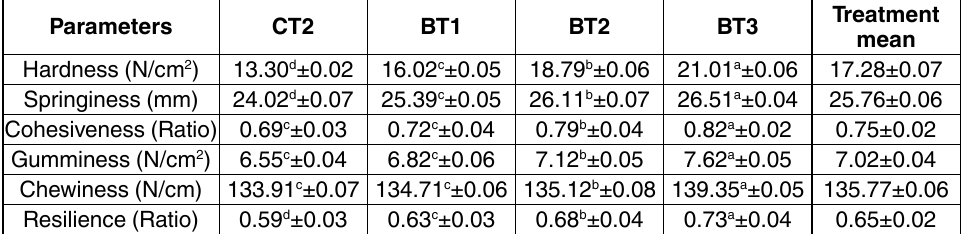
table 3. Effect of pearl millet flour on textural parameters (Mean±SE) of chicken sausage Parameters